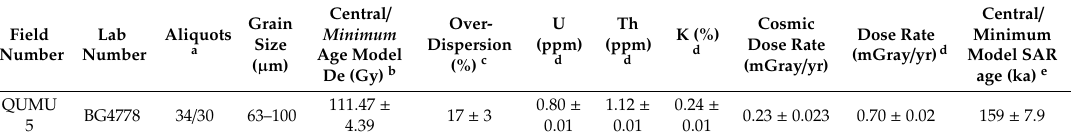
Table 2. Single Aliquot Regeneration, optically-stimulated luminescence (SAR-OSL) ages on quartz grains from a fluvial deposit (sample QUMU 5),